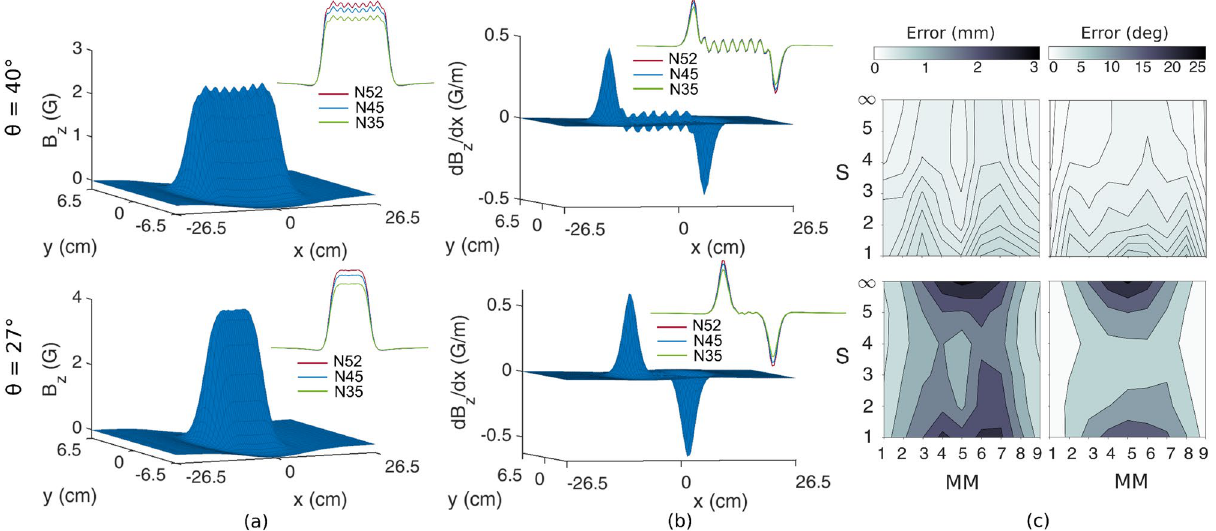
Figure 2. Results from two representative configurations (θ = 40°, upper panels, and θ = 27°, lower panels—N45 grade magnets). ( a ) Spatial distribution of the magnetic field z-component (B z ) measured by the sensor plane (S ∞ ); insets: B z for all magnet grades measured for y = 0 cm. The magnetic field appears as the linear combination of bell-shaped waveforms, each one generated by one magnet. For θ = 40°, the peaks of the bells are always clearly distinguishable, while the ripple becomes less evident for θ = 27°. ( b ) B z gradient (along x) on S ∞ ; insets: Bz gradient (along x) for all magnet grades measured for y = 0 cm. Peaks corresponding to different magnets proved more (less) evident for θ = 40° (27°). ( c ) Contour plots displaying position (on the left) and orientation (on the right) e m and e ct , for all sensing areas and all MMs (95th percentile). Good accuracies were achieved for θ = 40°, vice-versa errors increased for θ = 27°. In both cases, e ct decreased when moving from the central towards external